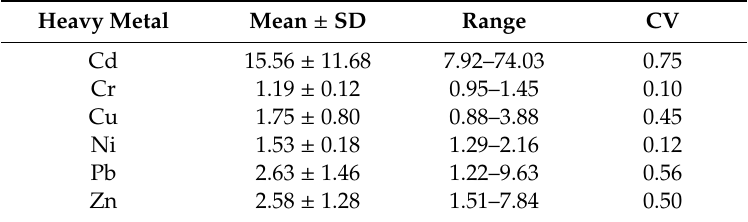
Table 10. Descriptive statistics for the enrichment factors (EF) of heavy metals and their coe ffi cient of variation (CV) values.